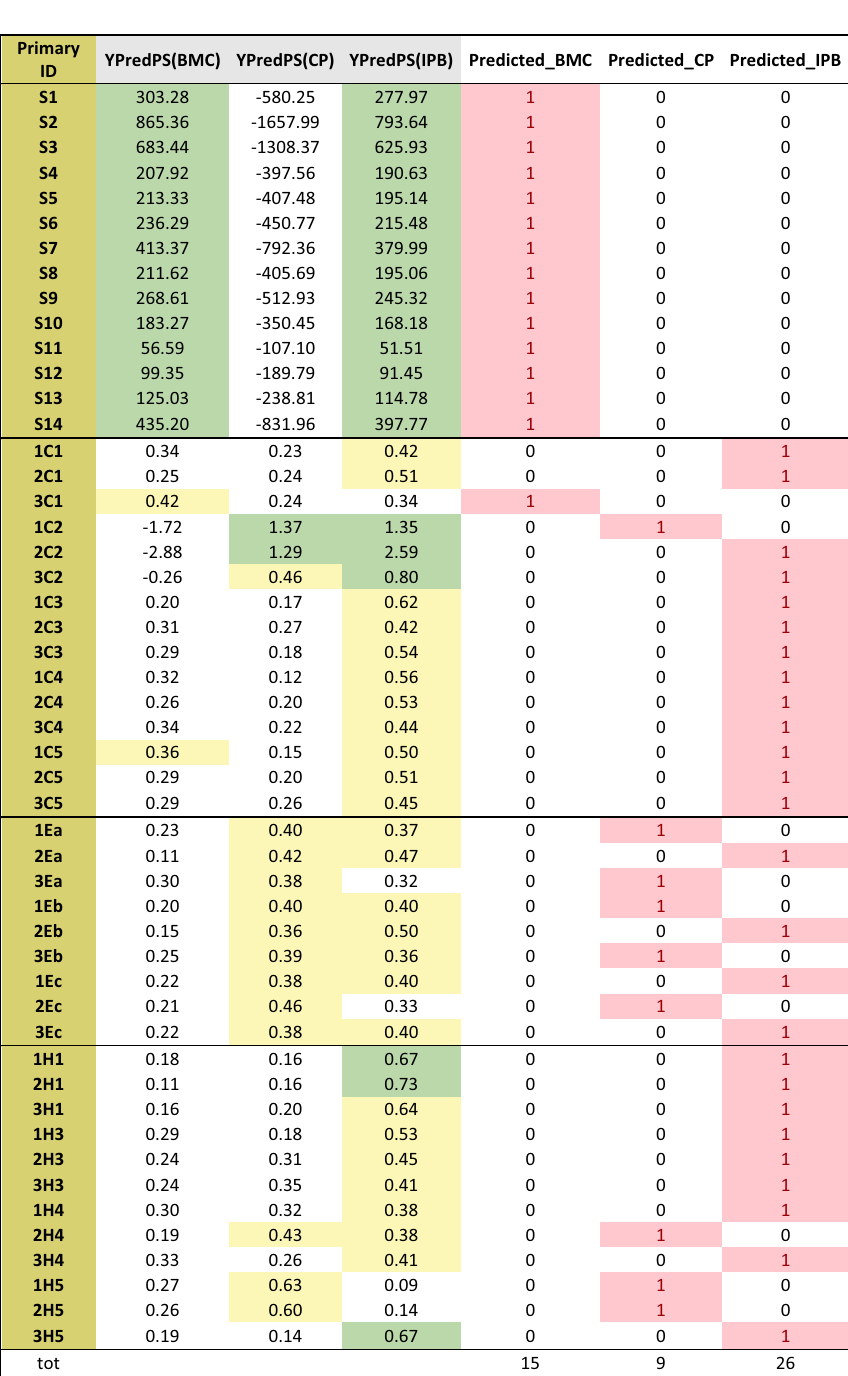
Table 2. Prediction test on the external validation set. Observations are colored based on YpredPS values: i. < 0.35 white (do not belong to the class); ii. 0.35–0.65 yellow (borderline); iii. > 0.65 green (belong to the class). The class attribution is based on the major value of YpredPS